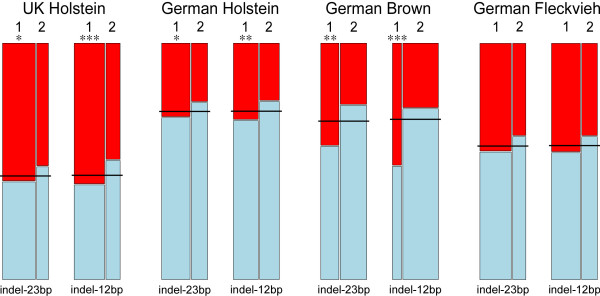
Allele Frequencies. Allele frequencies of the 23- and 12-bp insertion/deletion polymorphisms in UK Holstein, German Holstein, German Brown and German Fleckvieh BSE affected (red) and control (light-blue) animals. "1" and "2" above the columns represent the deletion and insertion alleles, respectively. The horizontal black lines indicate the expected proportions of cases and controls in each class. The thickness of the columns is proportional to the allele frequency. Asterisks indicate the level of significance: * < 0.05, ** < 0.01, *** < 0.001.